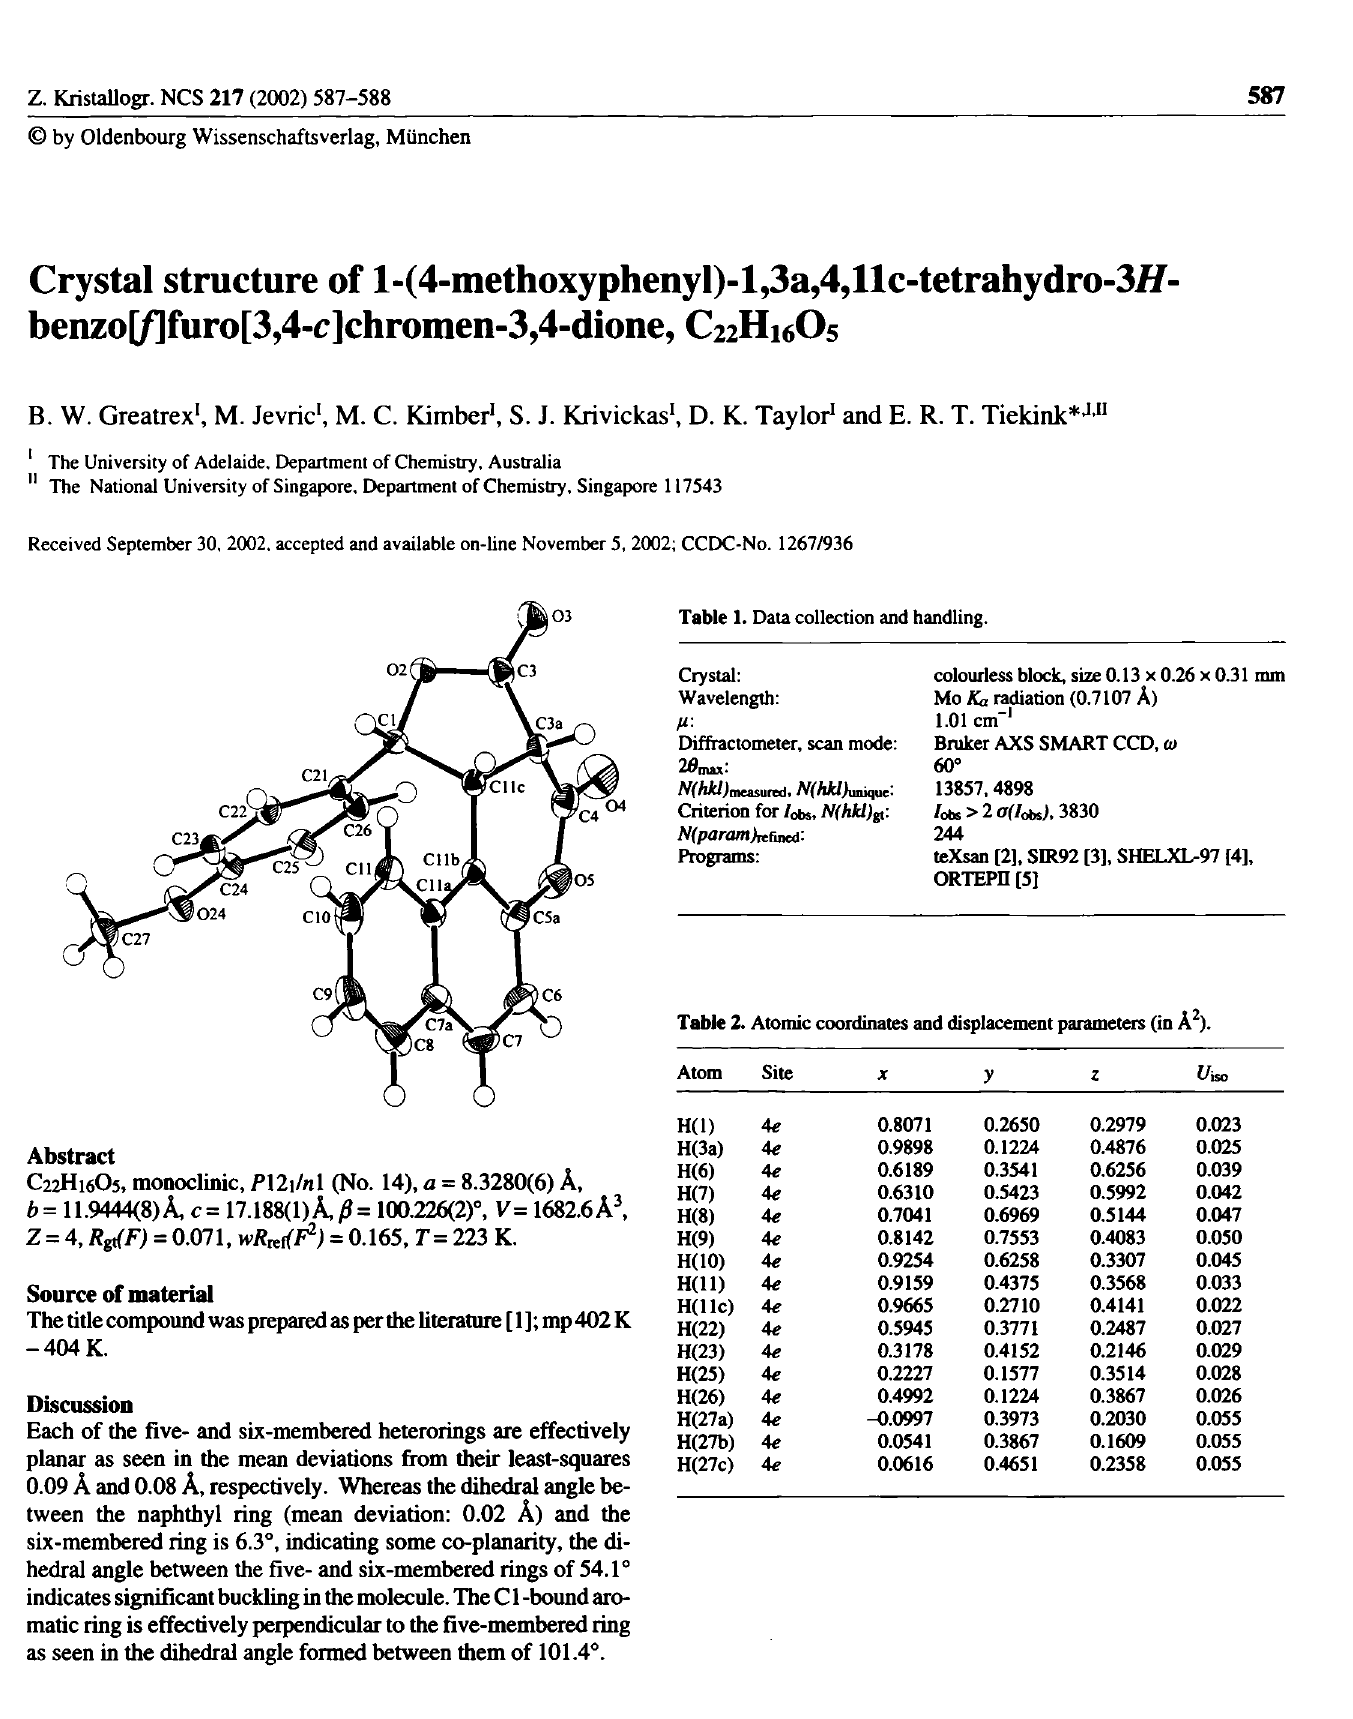
Table 2. Atomic coordinates and displacement parameters (in À 2